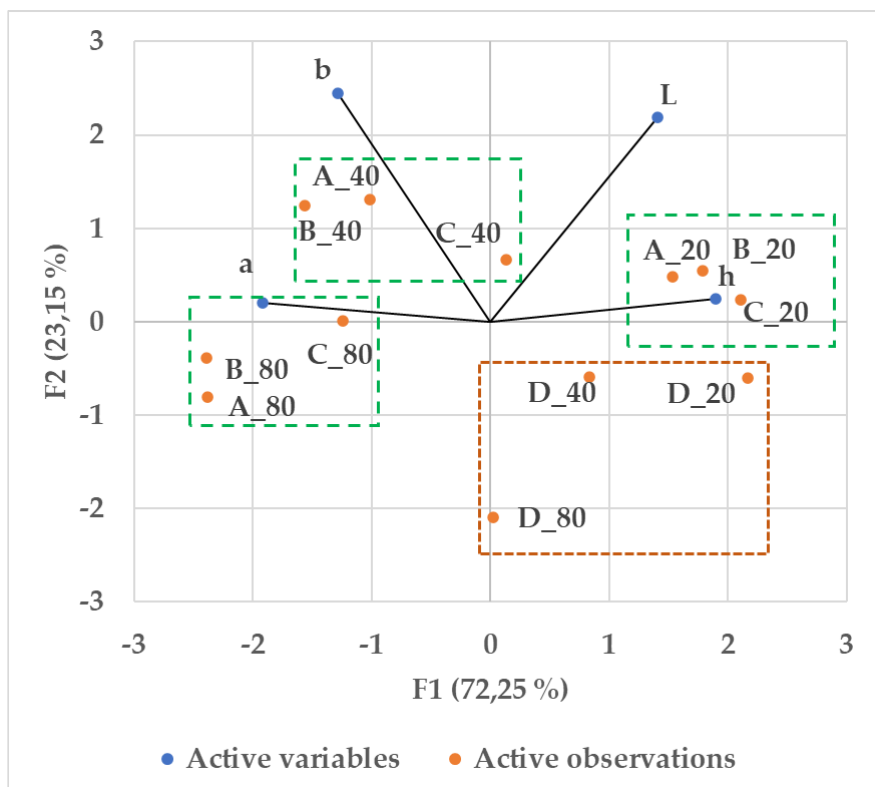
Figure 6. Principal component analysis (PCA) score plot for mistletoe macerates obtained after 28 days of mistletoe maceration (20 g/L, 40 g/L, and 80 g/L; ethanol – water solution A: 25%, B: 40%, C: 55%, and D: 70% v/v ethanol) at room temperature and in darkness, based on macerate chromate characteristics: L-luminosity, a, b-chromaticity coordinates, h-hue. Highlighted in red - samples with increasing ethanol concentration and decreasing brightness values.